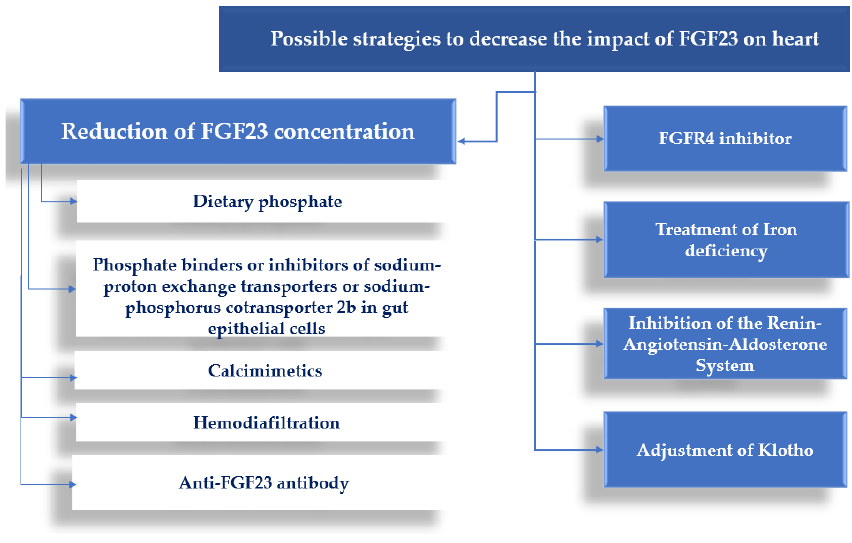
Figure 1. The potential approach for reducing the FGF23 effect on the